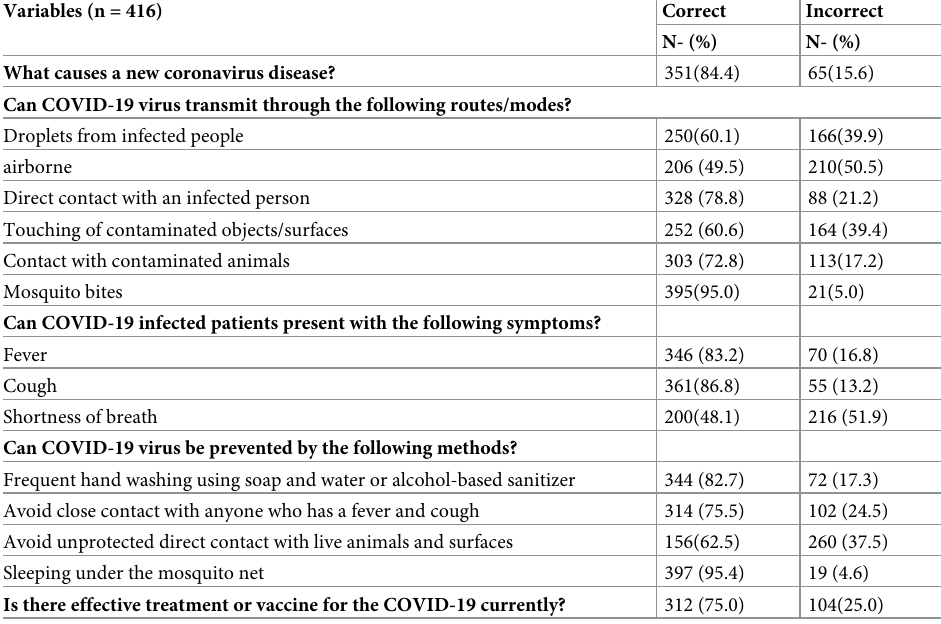
Table 2. Knowledge of COVID-19 among waiters working in food and drinking establishments, Southwest Ethio- pia,